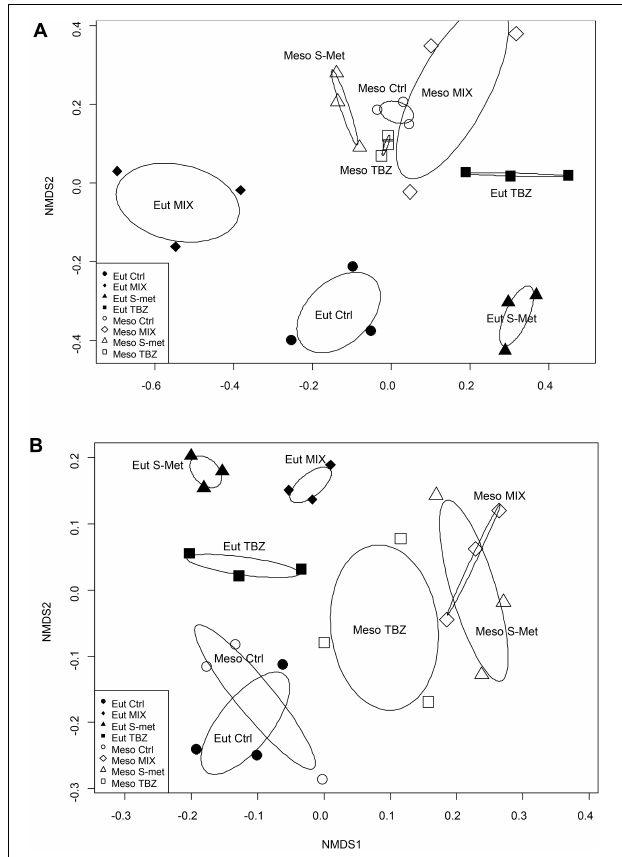
FIGURE 3 | Non metric dimensional scaling (NMDS) performed on samples at the end the experiment (day 40) representing fungal (A) and bacterial (B) community structure with ellipses representing standard deviation of samples within each treatment and nutrient condition.